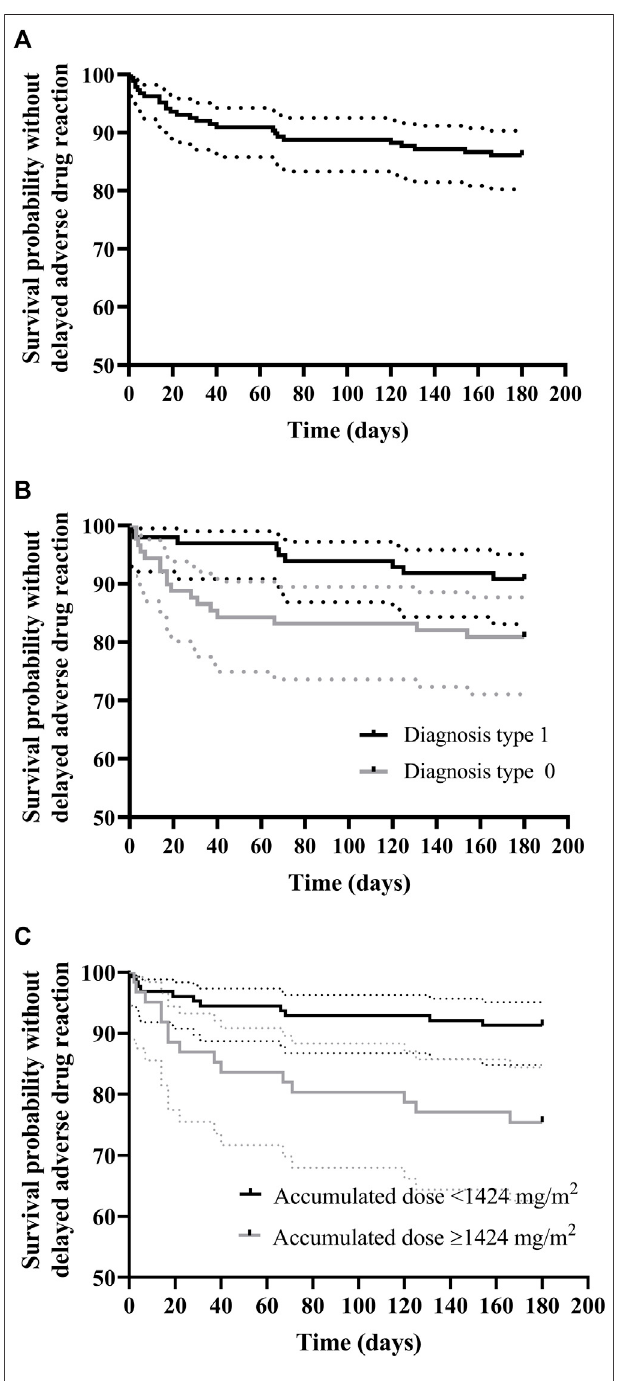
FIGURE 3 | Kaplan – Meier curve for rituximab delayed adverse drug reaction-free survival (A) and survival according to (B) diagnosis and (C) cumulative dose normalized by body-surface area (mg/m 2 ). (A) Delayed ADR- free survival was 86.1% (95% CI, 81.3 – 91.2) at 166 days post initiation of rituximab therapy; (B) Delayed ADR-freesurvival for diagnosis 0 (O-HSCT-SOT) was80.9%(95%CI,73.1 – 89.5)at154 dayspost-initiationofrituximabtherapy, whereas for diagnosis 1 (NIHR) it was 90.8% (95%CI, 85.3 – 96.7) at 166 days; (C) Delayed ADR-free survival for patients with cumulative dose normalized by body surface area (mg/m 2 ) ≥ 1,424 mg/m 2 was 81.1% (95% CI, 74.5 – 88.4) at ( Continued )